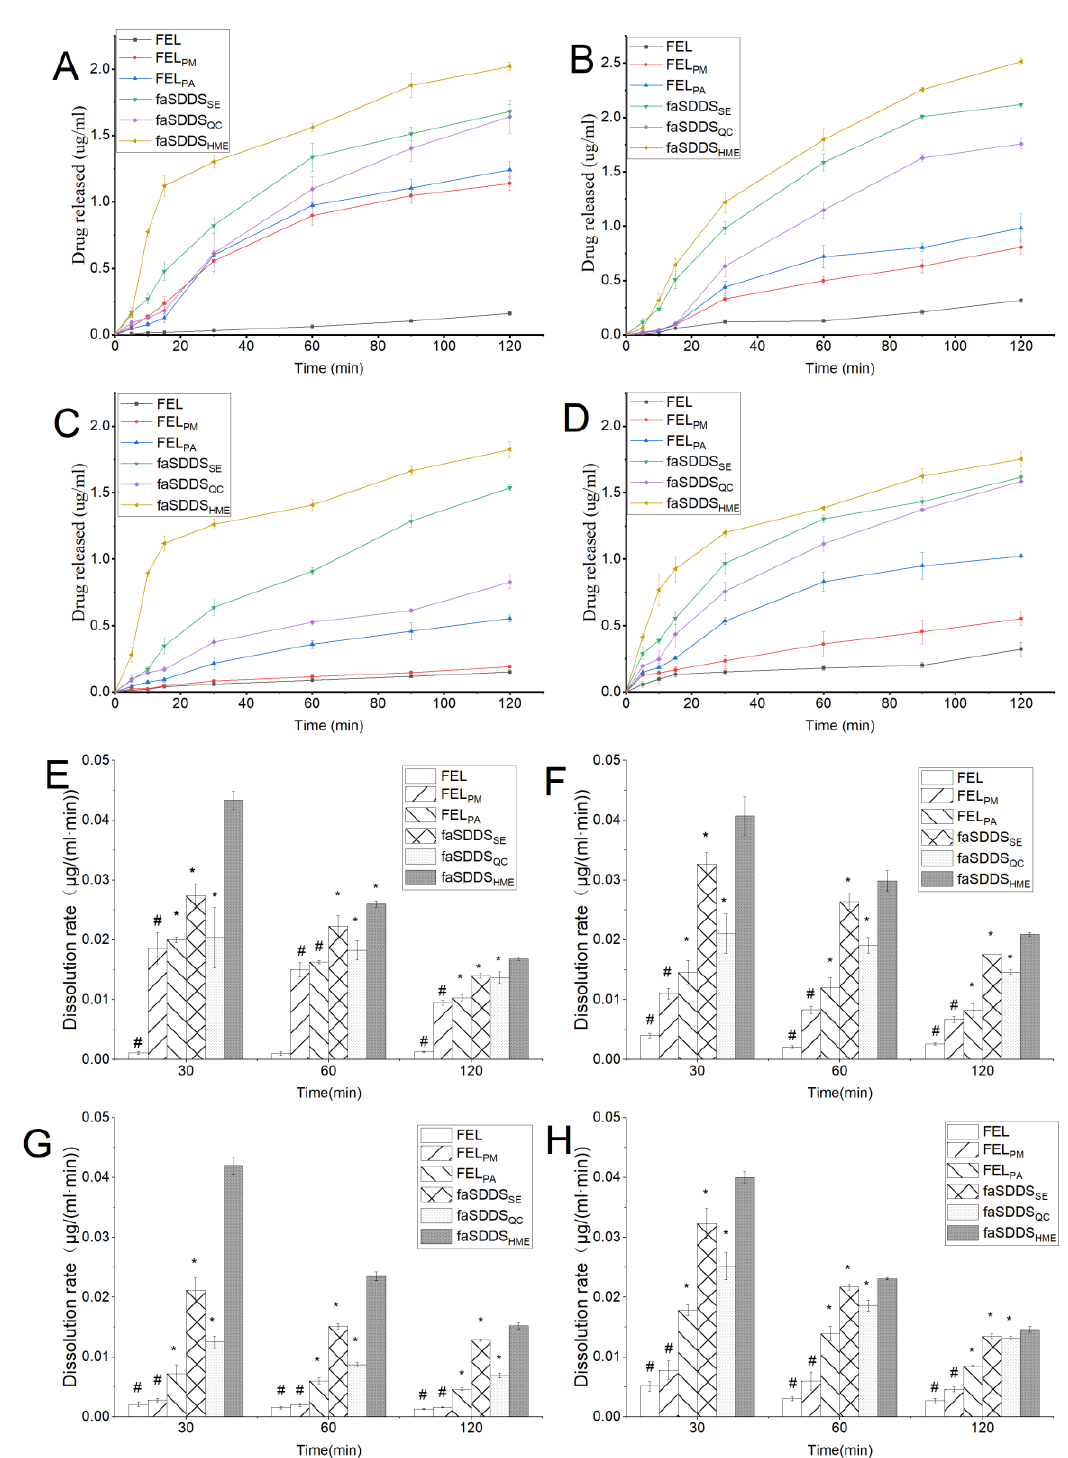
Figure 4. Dissolution profiles of FEL, FEL PM , FEL PA , faSDDS SE , faSDDS QC , and faSDDS HME in 0.1 mol/L HCl ( A ), PBS (pH 4.5, ( B )), PBS (pH 6.8, ( C )), and PBS (pH 7.5, ( D )). Dissolution rates were calculated at 30, 60 and 120 min for FEL-related samples in 0.1 mol/L HCl ( E ), PBS (pH 4.5, ( F )), PBS (pH 6.8, ( G )), and PBS (pH 7.5, ( H )). # p < 0.05, FEL and FEL PM vs. faSDDS SE , faSDDS QC , and faSDDS HME , * p < 0.05, faSDDS SE and faSDDS QC vs. faSDDS HME . Standard deviation expressed by error bars (n = 3).